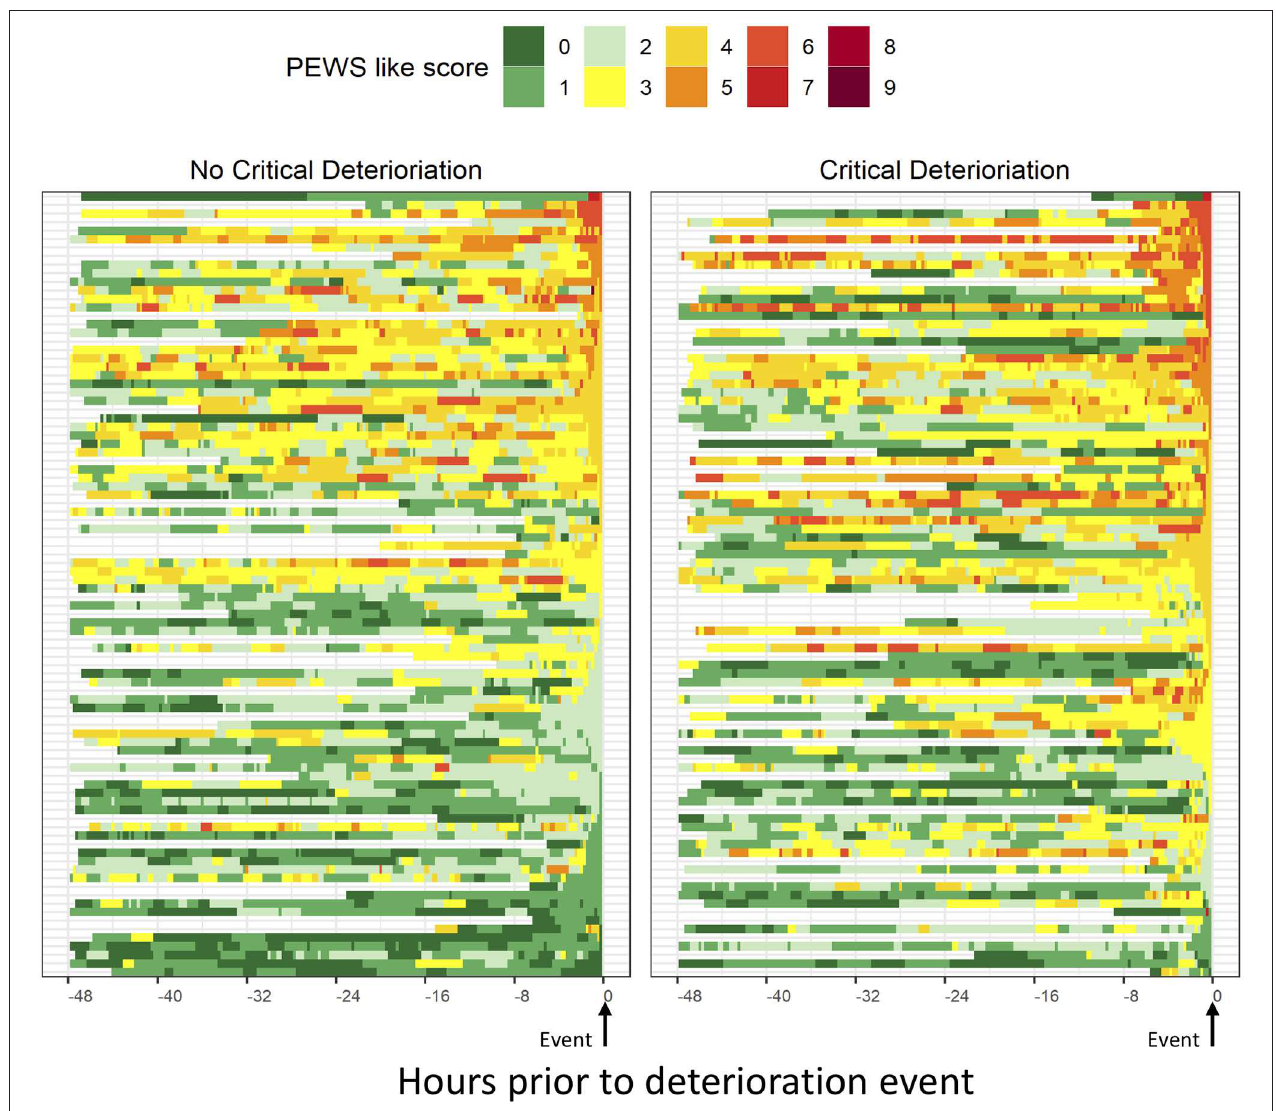
FIGURE 1 | PEWS-Like-Score (PEWS-LS) in the 48h prior to deterioration events with and without critical deterioration. PEWS-like-scores (PEWS-LS) were calculated using documented vital signs data in the 48-h prior to PICU admission or floor intervention using the PEWS tool and vital sign limits derived from those previously published (13, 15, 16). The PEWS-LS was constructed by summing cardiovascular (CV), Neurologic, and Respiratory scores in 15-min intervals. The CV score combined capillary refill and heart rate parameters. The neurological score was based on level of consciousness. The respiratory score was based on oxygen use, use, type, and flow of ventilation, oxygen saturation, and respiratory rate. Neurologic, CV, and Respiratory sub-scores each had a possible range of 0–3, with 3 representing the most abnormal score. The PEWS-like score was a sum of these 3 sub-scores and had a theoretical range of 0–9. Documented values were carried forward until a change was noted in the medical record or patient was admitted to the PICU. For patients with < 48h between hospital admission and PICU transfer, only the available period of vital signs was used for